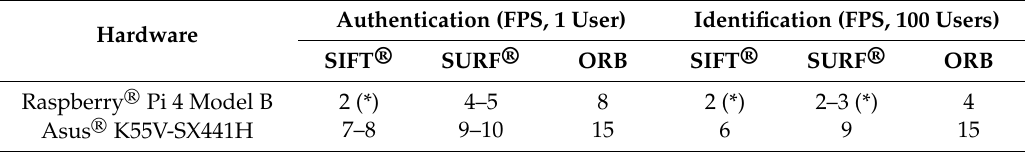
Table 2. Results: final system software. Processing-time performance in Frames Per Second (FPS) for the UC3M-CV1 database and its computing hardware using TGS-CVBR ® and PIS-CVBR ® with SIFT ® , SURF ® , and ORB algorithms. Authentication (FPS, 1 User) Identification (FPS, 100 Users) Hardware SIFT ® SURF